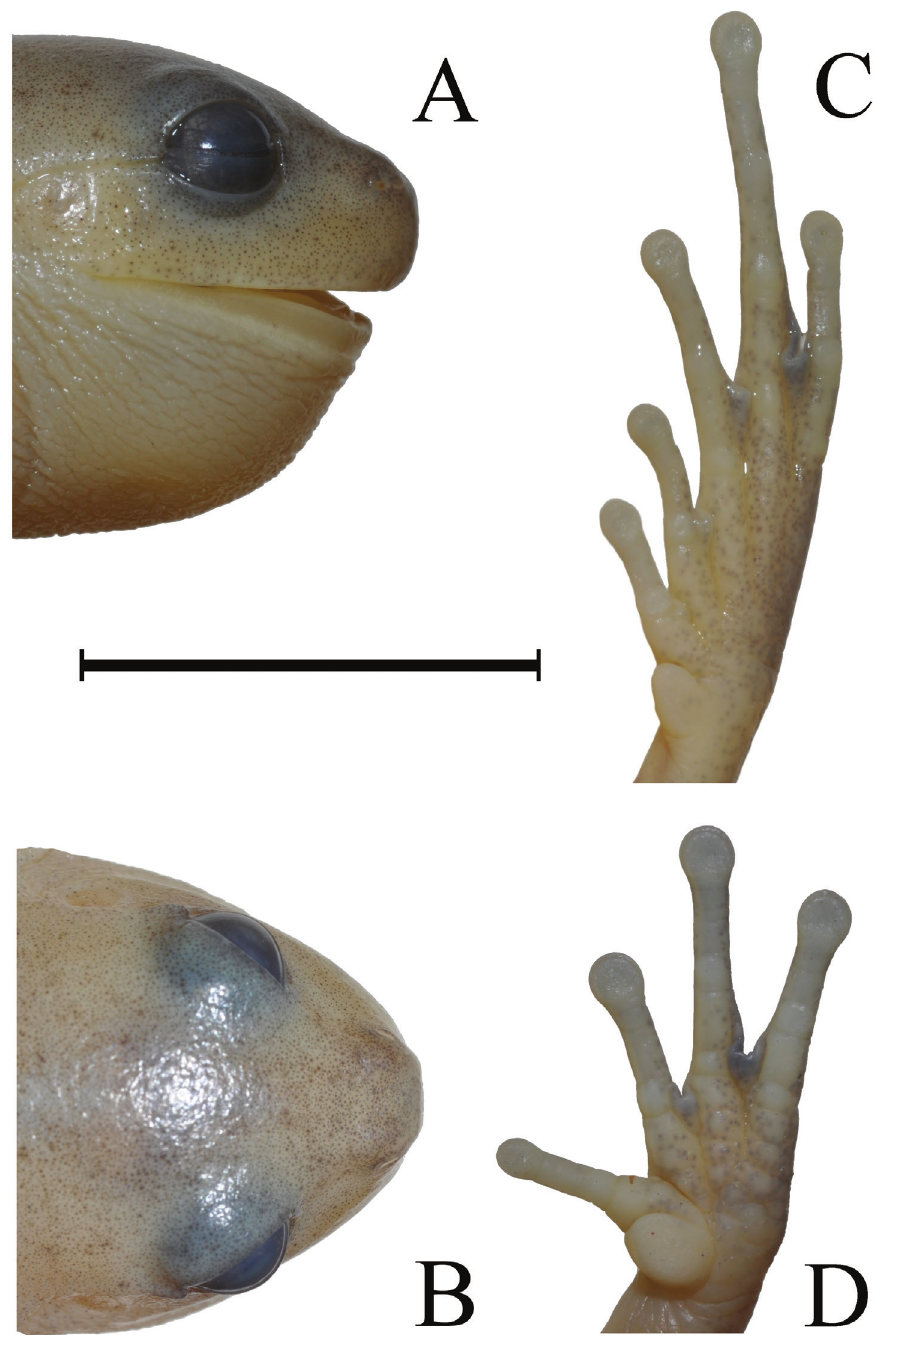
Figure 1. Holotype of Aplastodiscus lutzorum sp. n. (AAG-UFU 864). A Lateral view of head B dorsal view of head C plantar view D palmar view. Scale bar 12